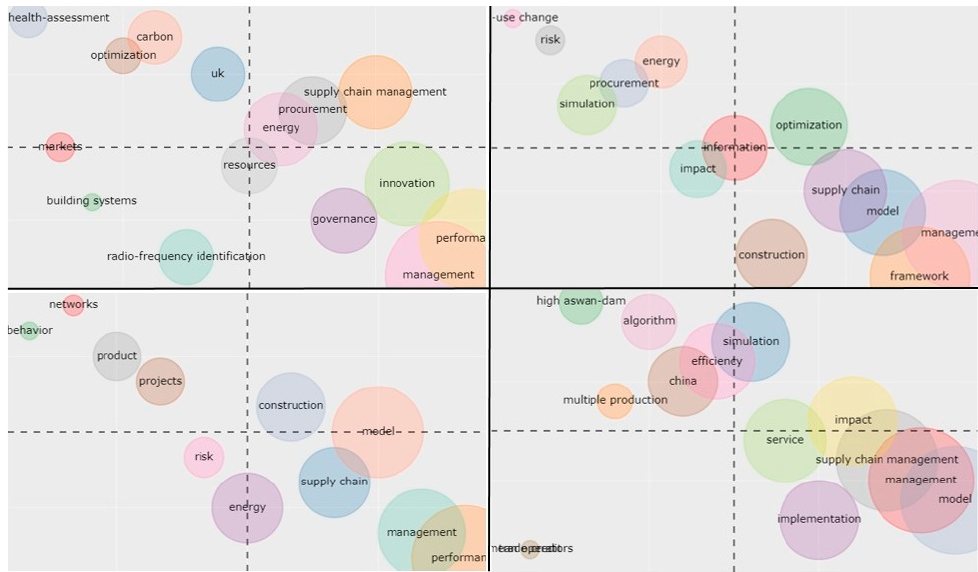
Figure 12 . Strategic diagrams of CSCM research (1998–2021)